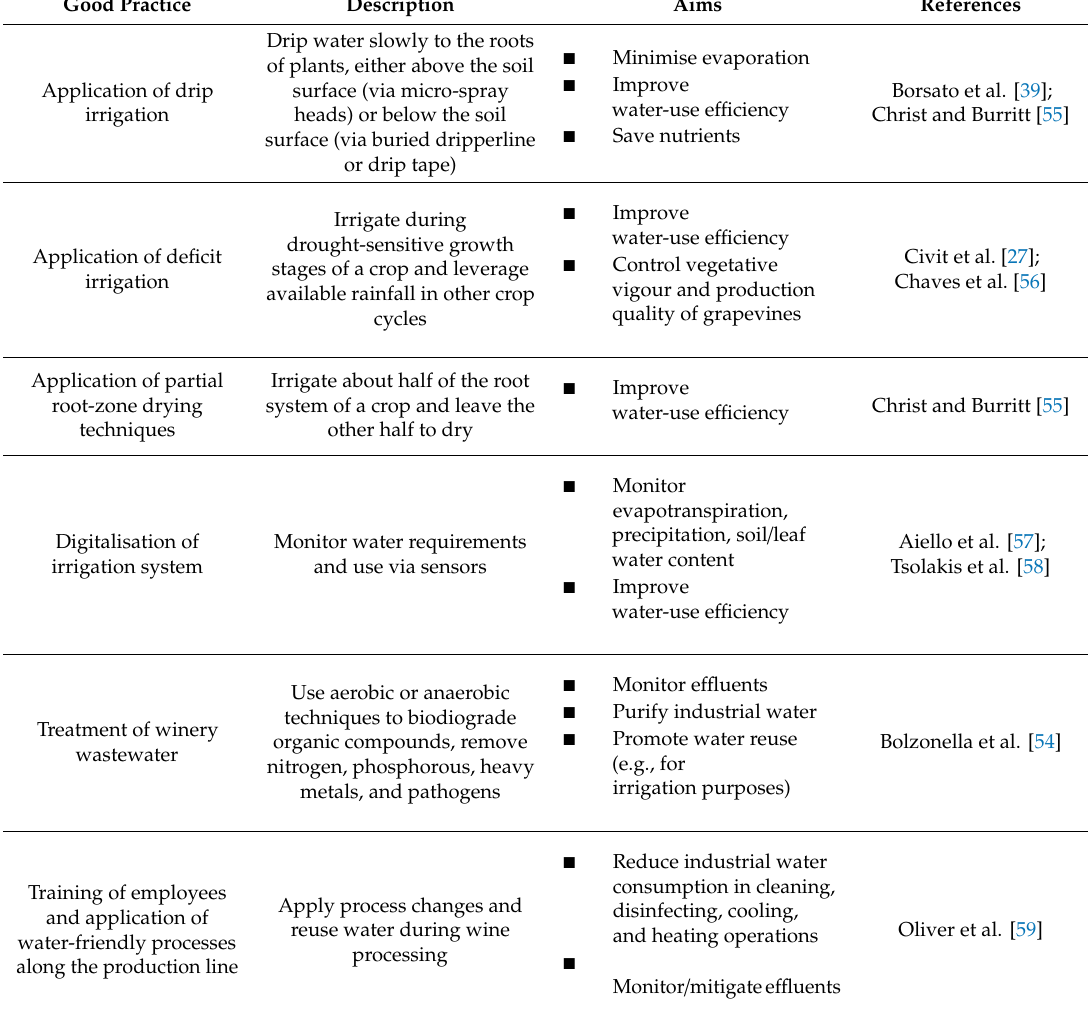
Table 3. Indicative good practices for water stewardship in the winemaking